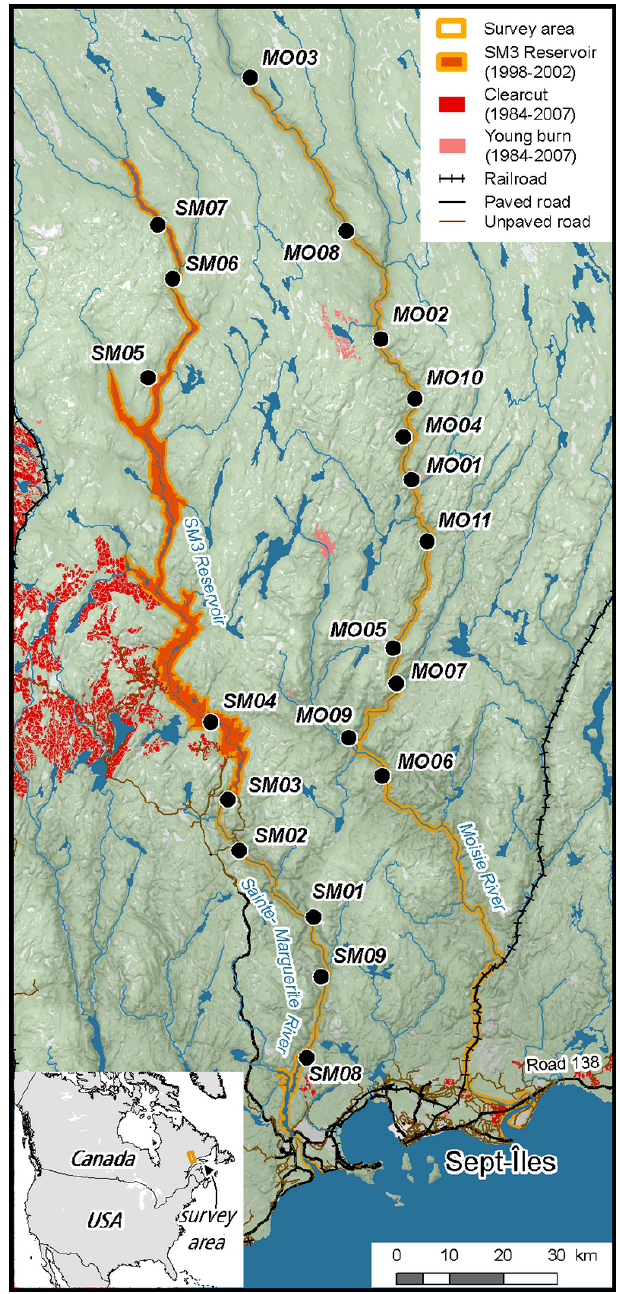
Fig. 1 . The study area and the survey